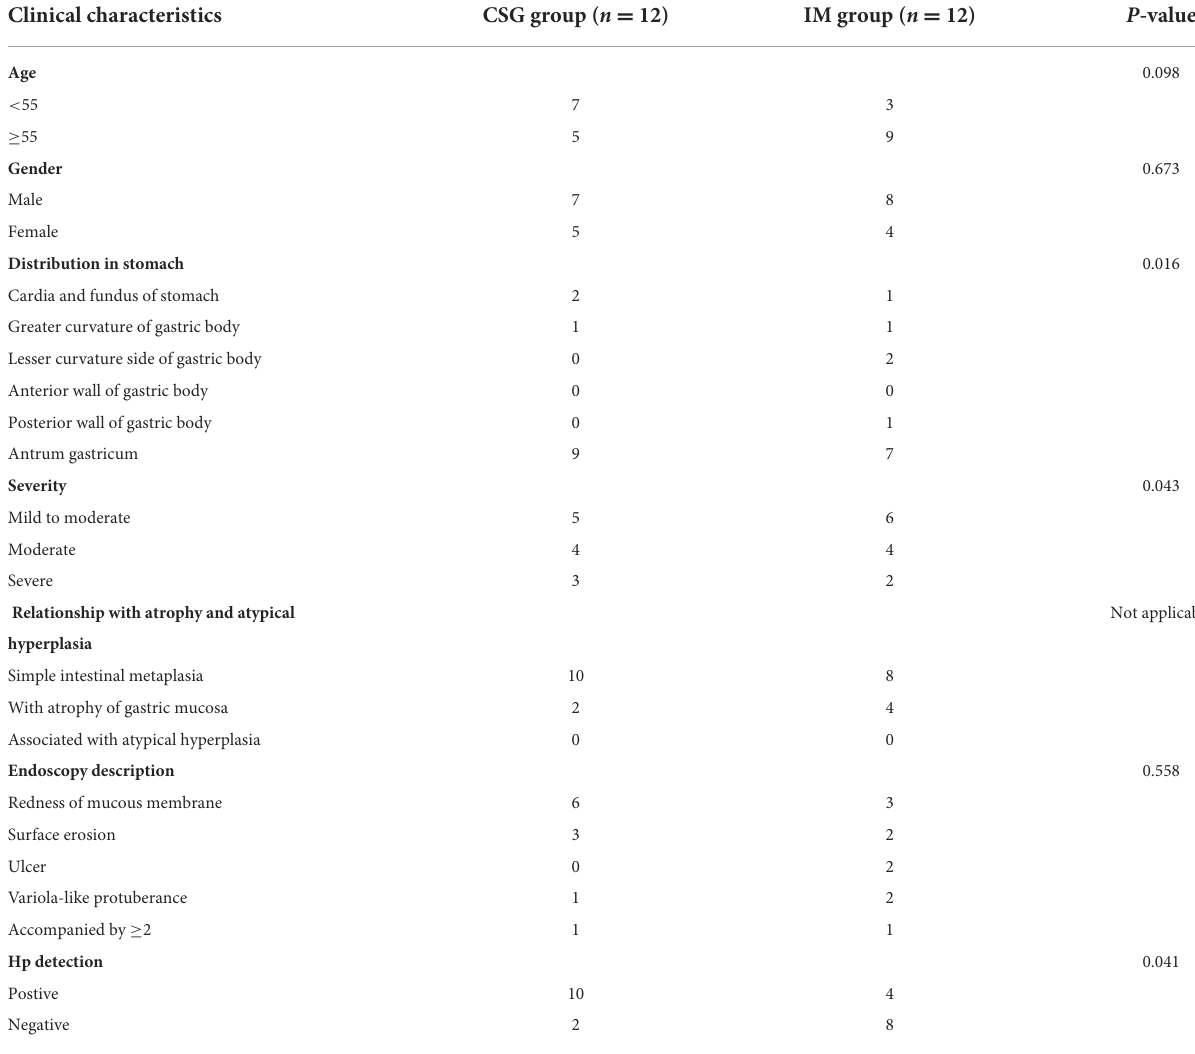
TABLE 2 The clinical characteristics of the CSG and IM patients. Clinical